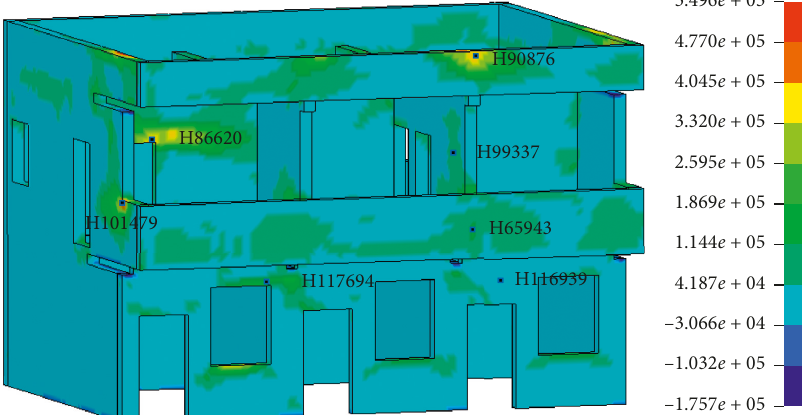
Figure 23: PTS contour of the structure ( t � 0.101s) [13] (unit: Pa).